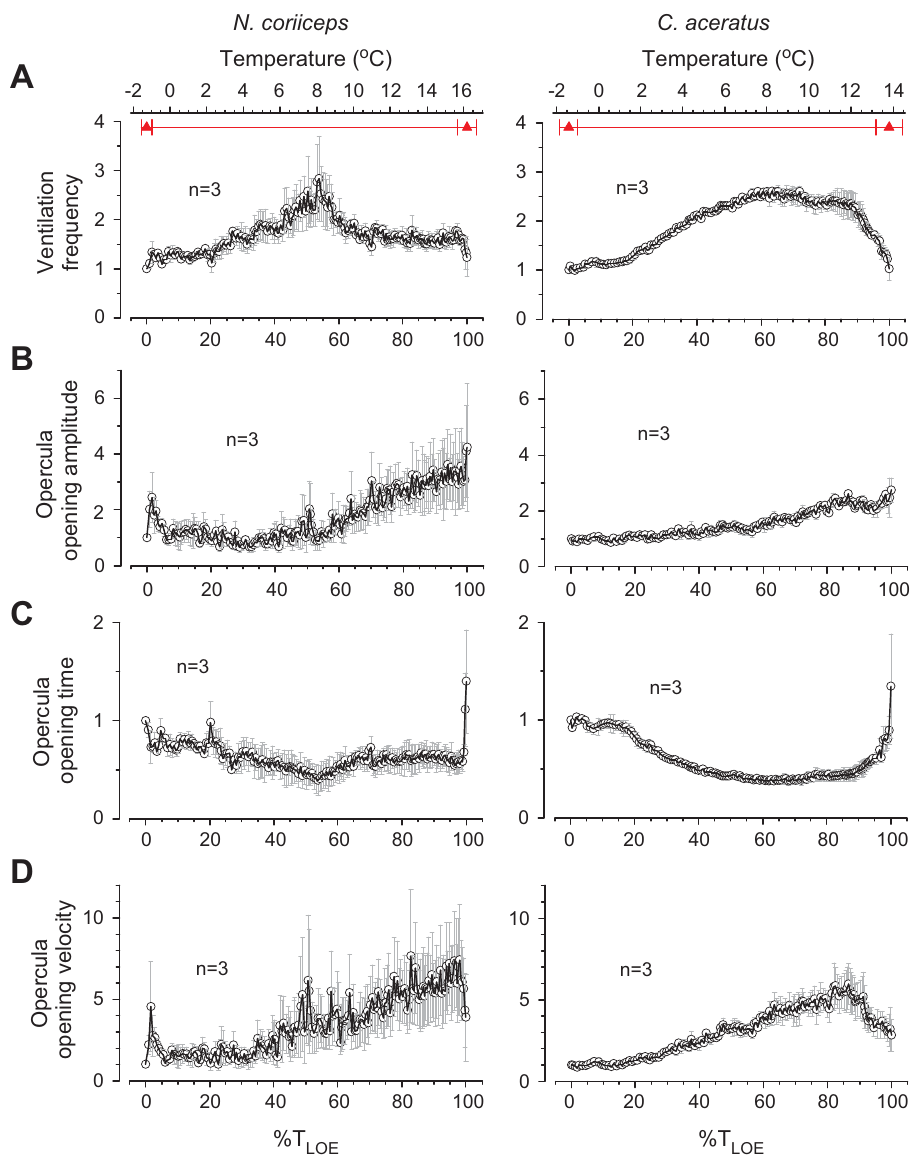
persistent till LOE (Fig 5B). Hb- fish, however, recruit this adjustment at the onset of hyper- ventilation, whereas Hb+ fish employ it when f changes of OT, however, are biphasic, and nearly mirror the inverse of changes in f species (Fig 5C), reaching their minima nearly coincident with the maximal f +8.5˚C. With further warming, C . aceratus maintain fast opercular openings (short OT) until the last 1–1.5˚C prior to LOE, whereas in N . coriiceps they become slower (longer OT).